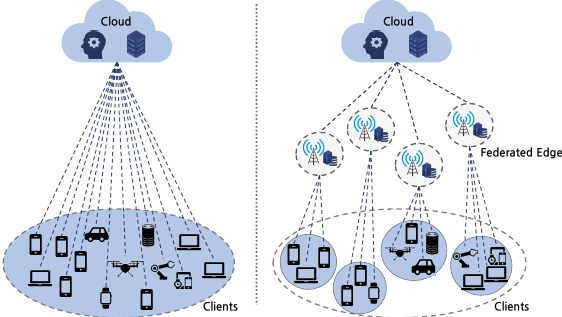
Figure 2. Communication burden comparison for clouds of FL ( top ) and FEEL ( bottom